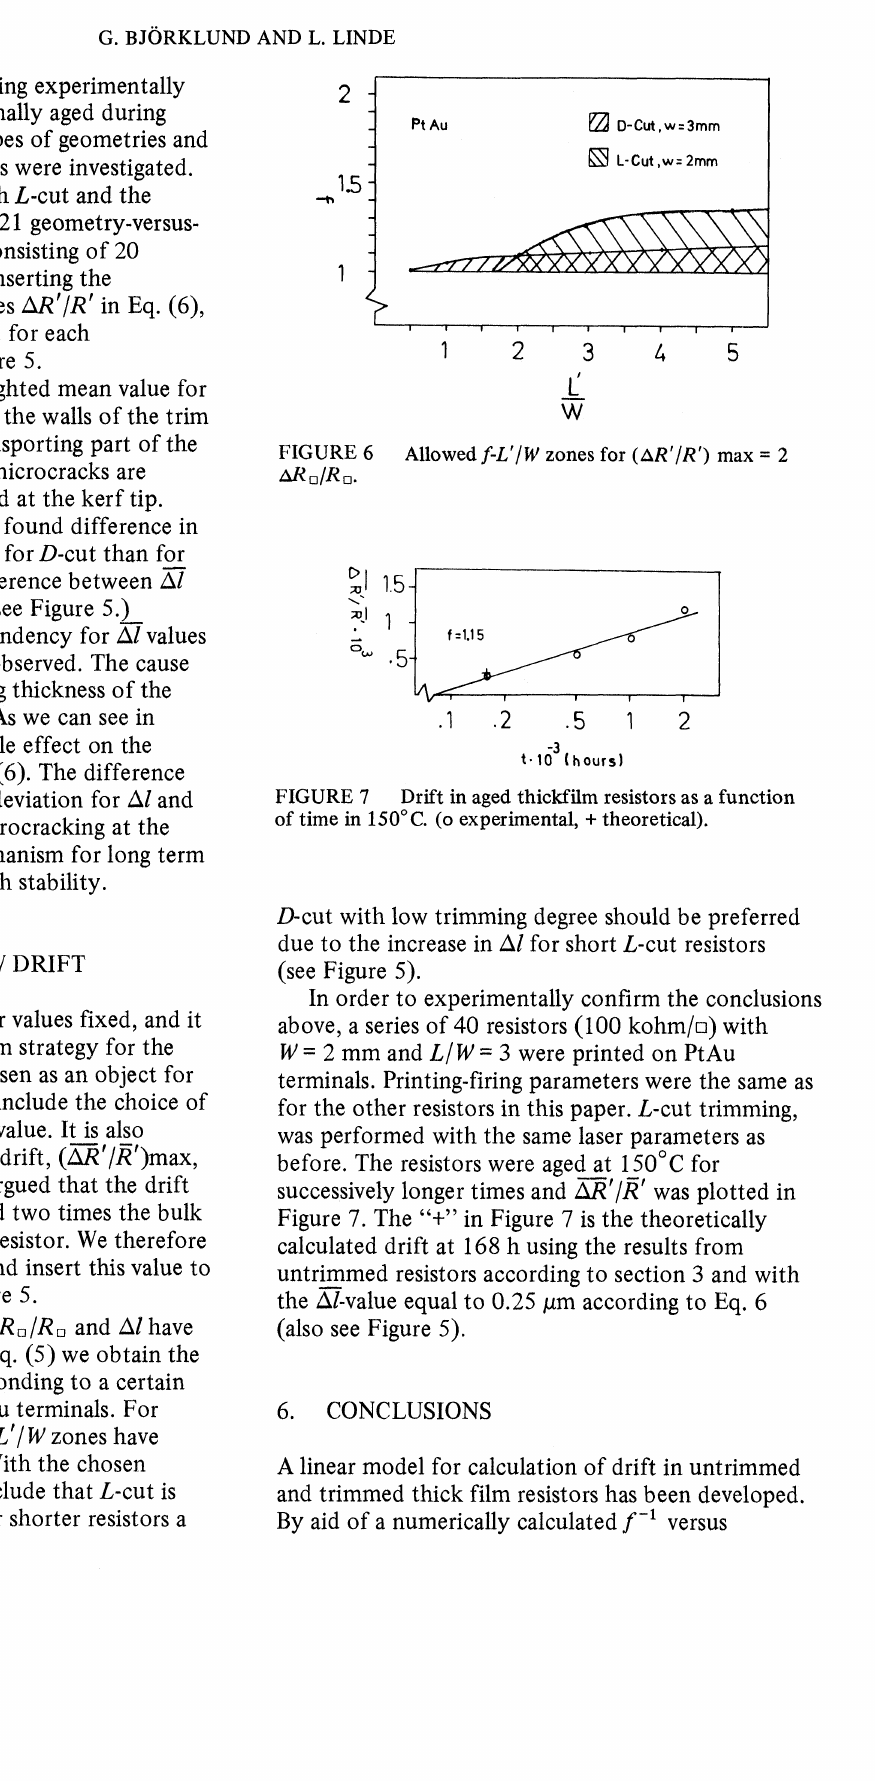
Drift in aged thickfilm resistors as a function of time in 150 C. (o experimental, + theoretical).